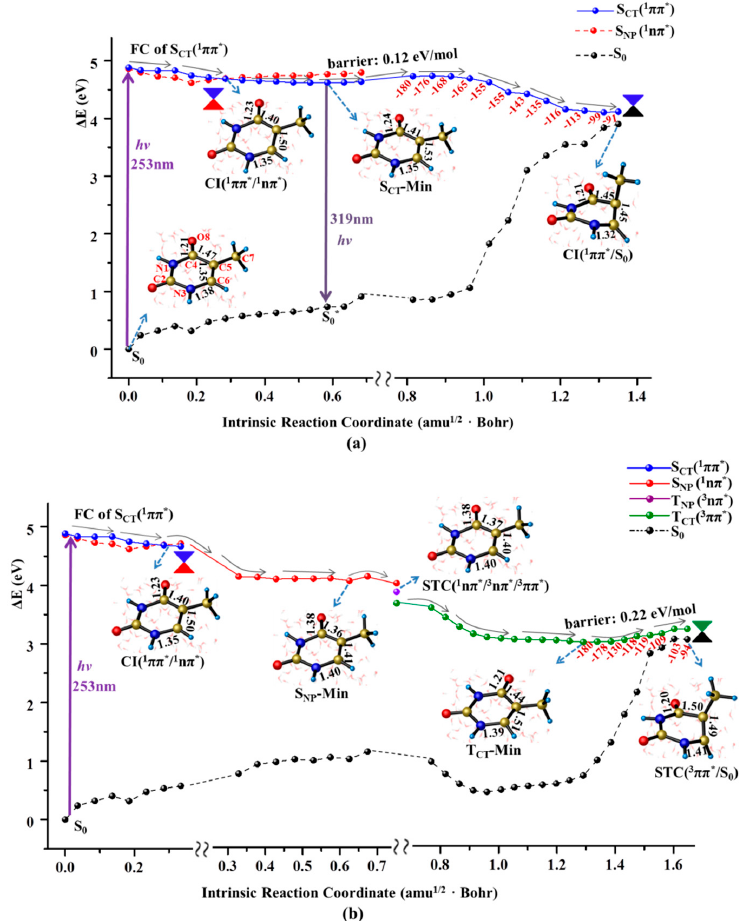
Figure 2. MEPs of two competitive deactivation paths for the thymine monomer in aqueous solution photo-initiated by 253 nm light in the bright S CT ( 1 ππ *) state ( a ) and T CT ( 3 ππ *) state ( b ). Schematic structures are shown with the selected bond lengths (in Å) and the changes of N1C4C5C7 dihedral angle are given along the relaxation path (the red numbers in degree).